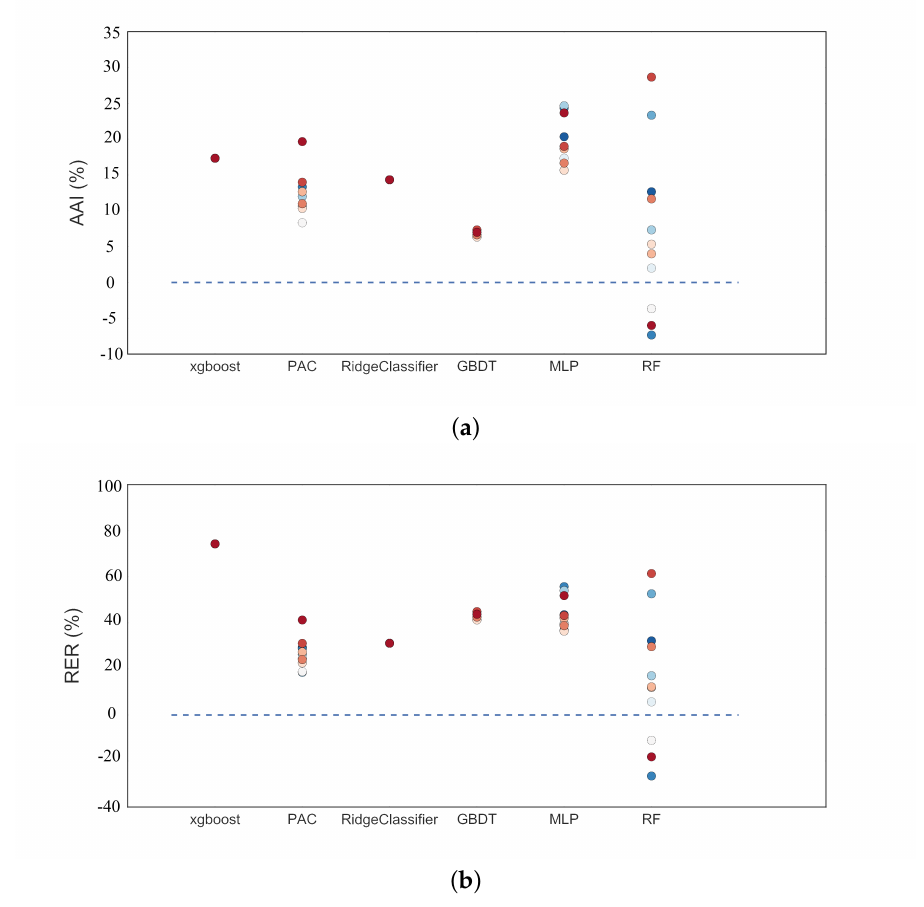
Figure 4. The accuracies ( a ) increase and ( b ) relatively error reduction under different machine learning algorithms and shuffle